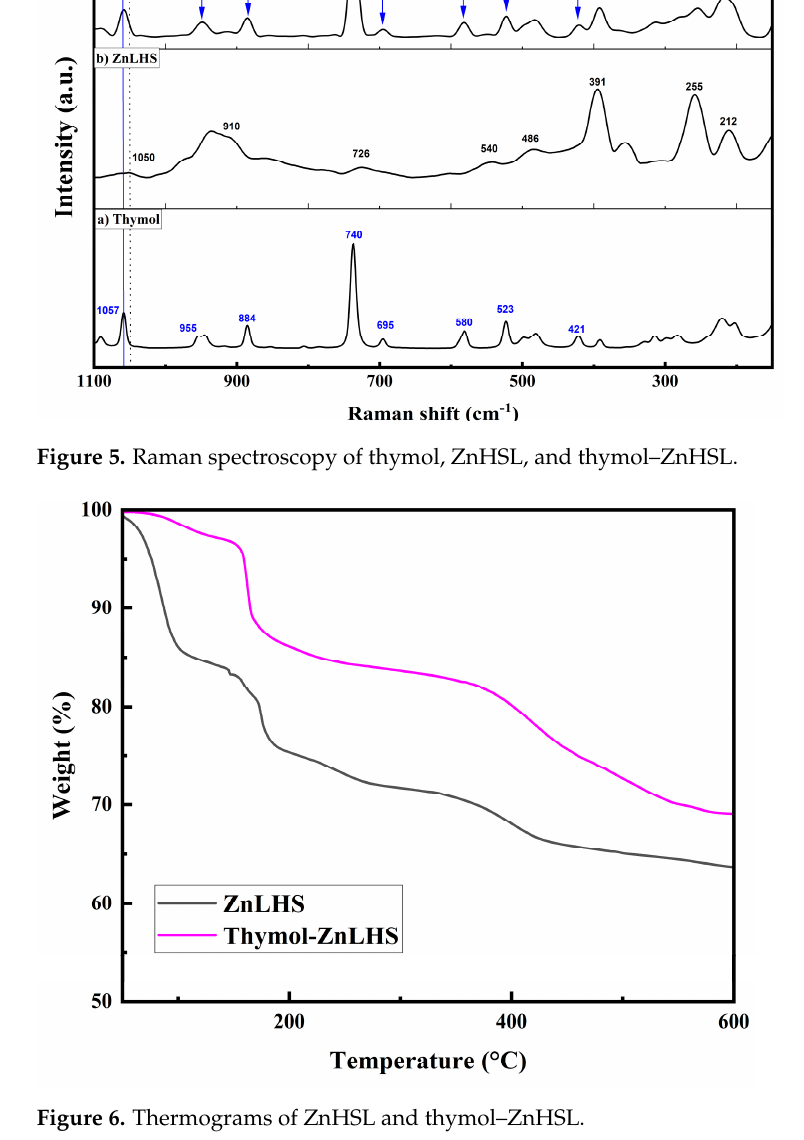
Figure 6. Thermograms of ZnHSL and thymol–ZnHSL.